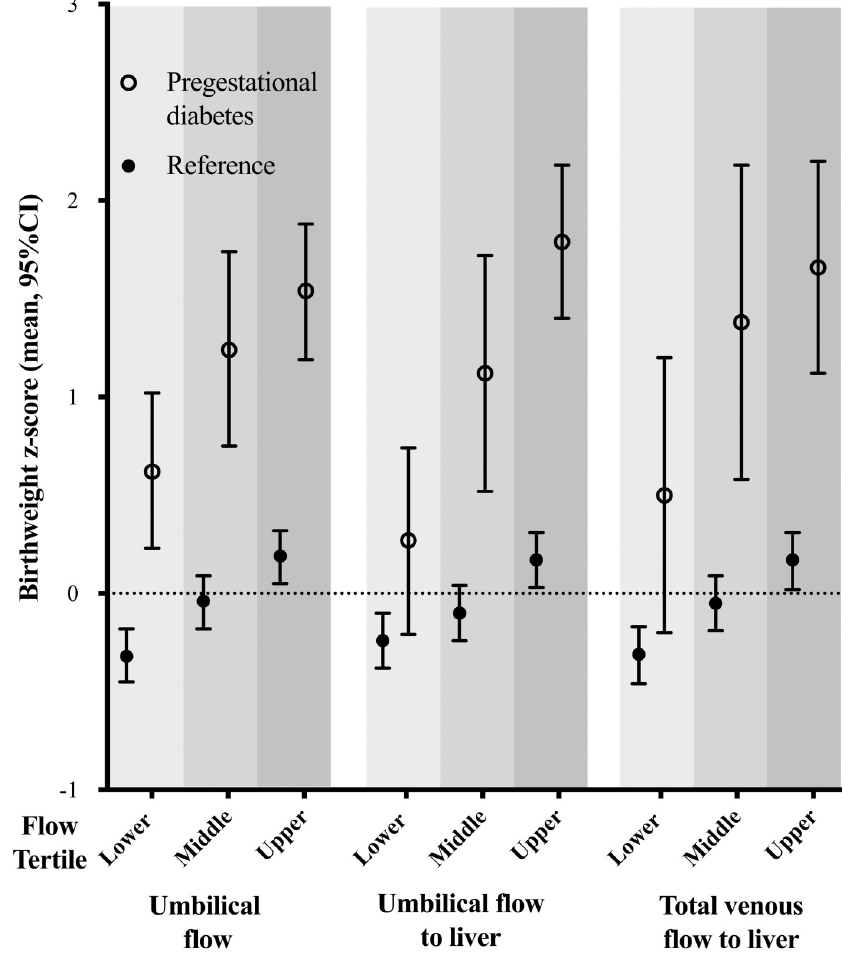
Fig 2. Birthweight z-scores in fetal flow tertiles in the study population with pregestational diabetes mellitus (PGDM) and the reference group. Flow variables were divided into tertiles defined by the distribution in the reference